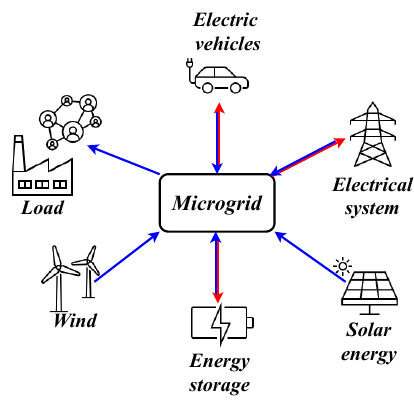
Figure 1. Components of a